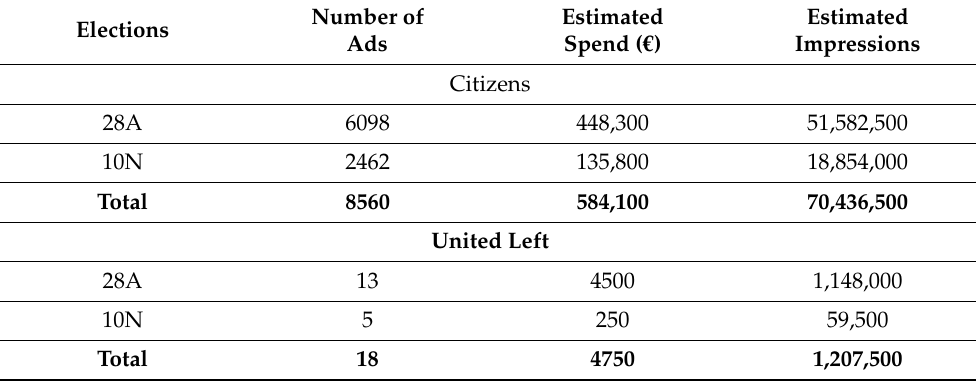
Table 1. Number of ads, estimated impressions, and spend by party ( n = 14,684). Source: Own